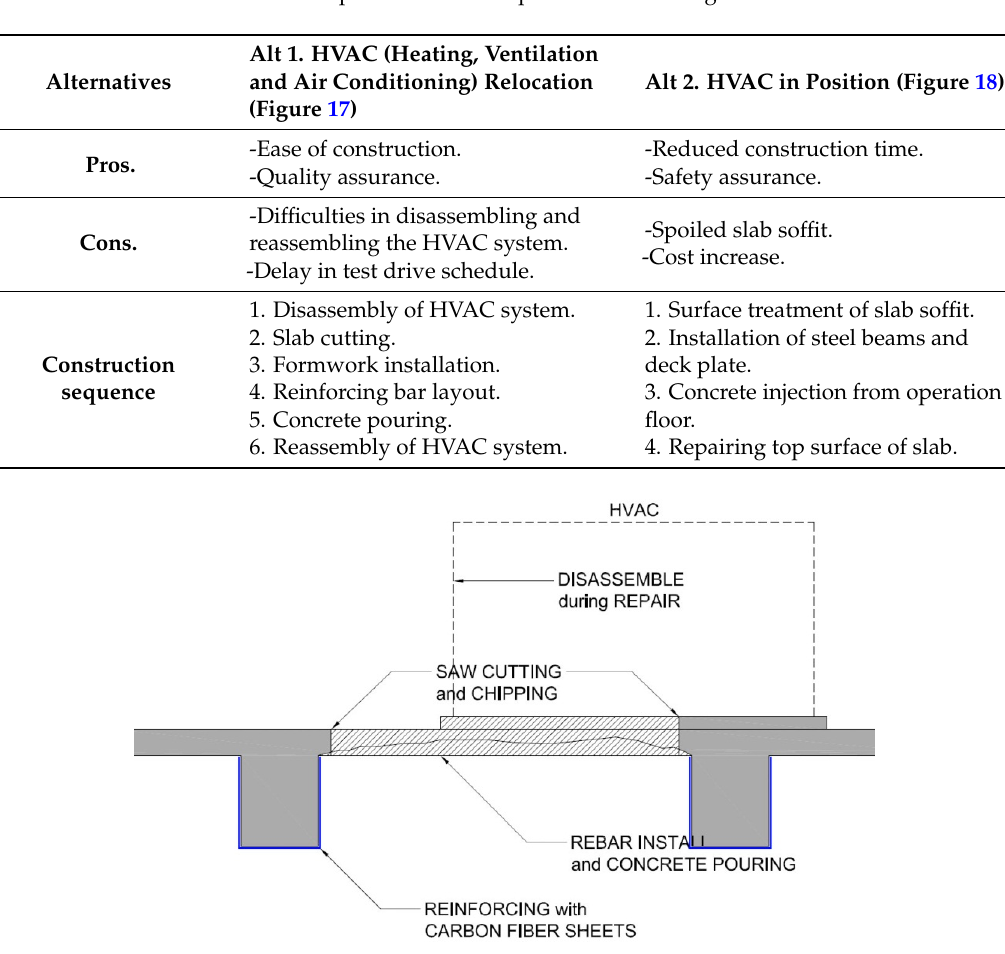
Figure 17. Rehabilitation plan with HVAC (Heating, Ventilation and Air Conditioning) removed during rehabilitation work.